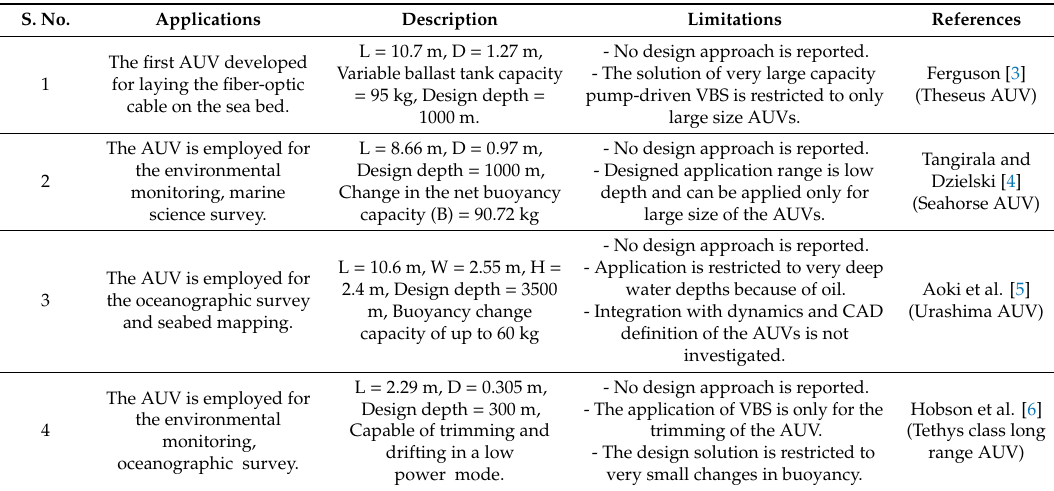
Table 1. List of the Underwater Vehicles (UVs) that use the Variable Buoyancy System (VBS) and their